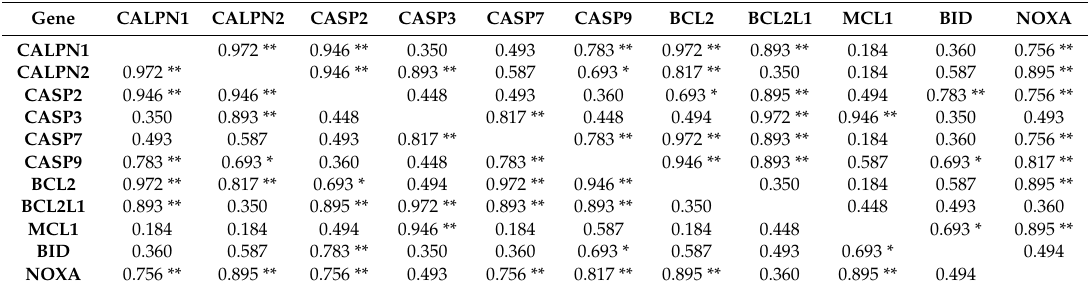
Table 5. Correlation analysis of apoptosis related-genes in the kidney of chicken.